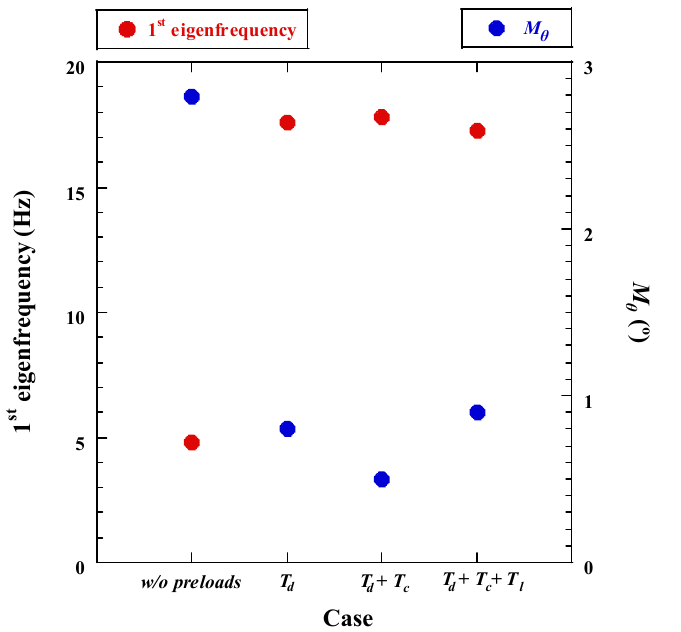
Figure 4. Variation of the 1st eigenfrequency and rotational angle according to the preloaded con ‐ ditions.